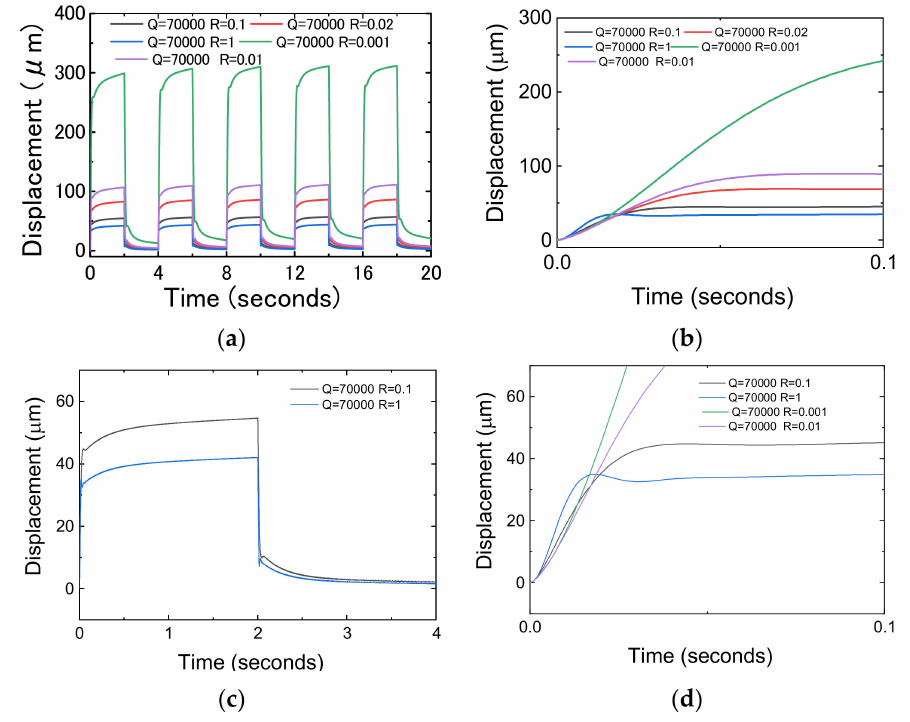
Figure 5. LQR simulation results comparison: ( a ) varying R; ( b ) Close-up view of ( a ) for the first 100 ms; ( c ) For one voltage cycle; and, ( d ) Close-up view of ( a ) for the first 100 ms and upper cut-o ff of 70 µ